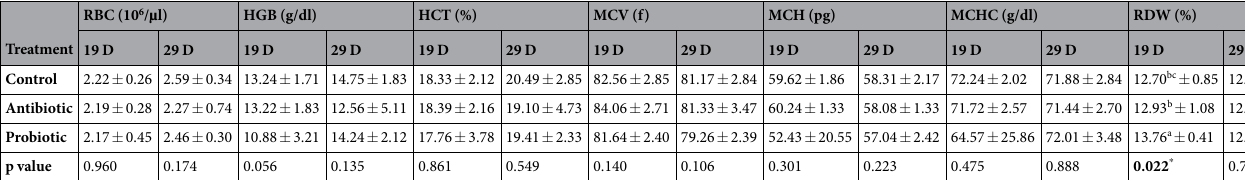
Table 2. Mean ( ± standard deviation) erythrocyte count and haemoglobin content (HGB), haematocrit value (HCT), mean corpuscular volume (MCV), mean corpuscular haemoglobin (MCH), mean corpuscular haemoglobin concentration (MCHC) and erythrocytes cell distribution width (RDW) of broilers receiving different treatments. * p < 0.05, a, b c Means within columns with different superscripts differ significantly (p <